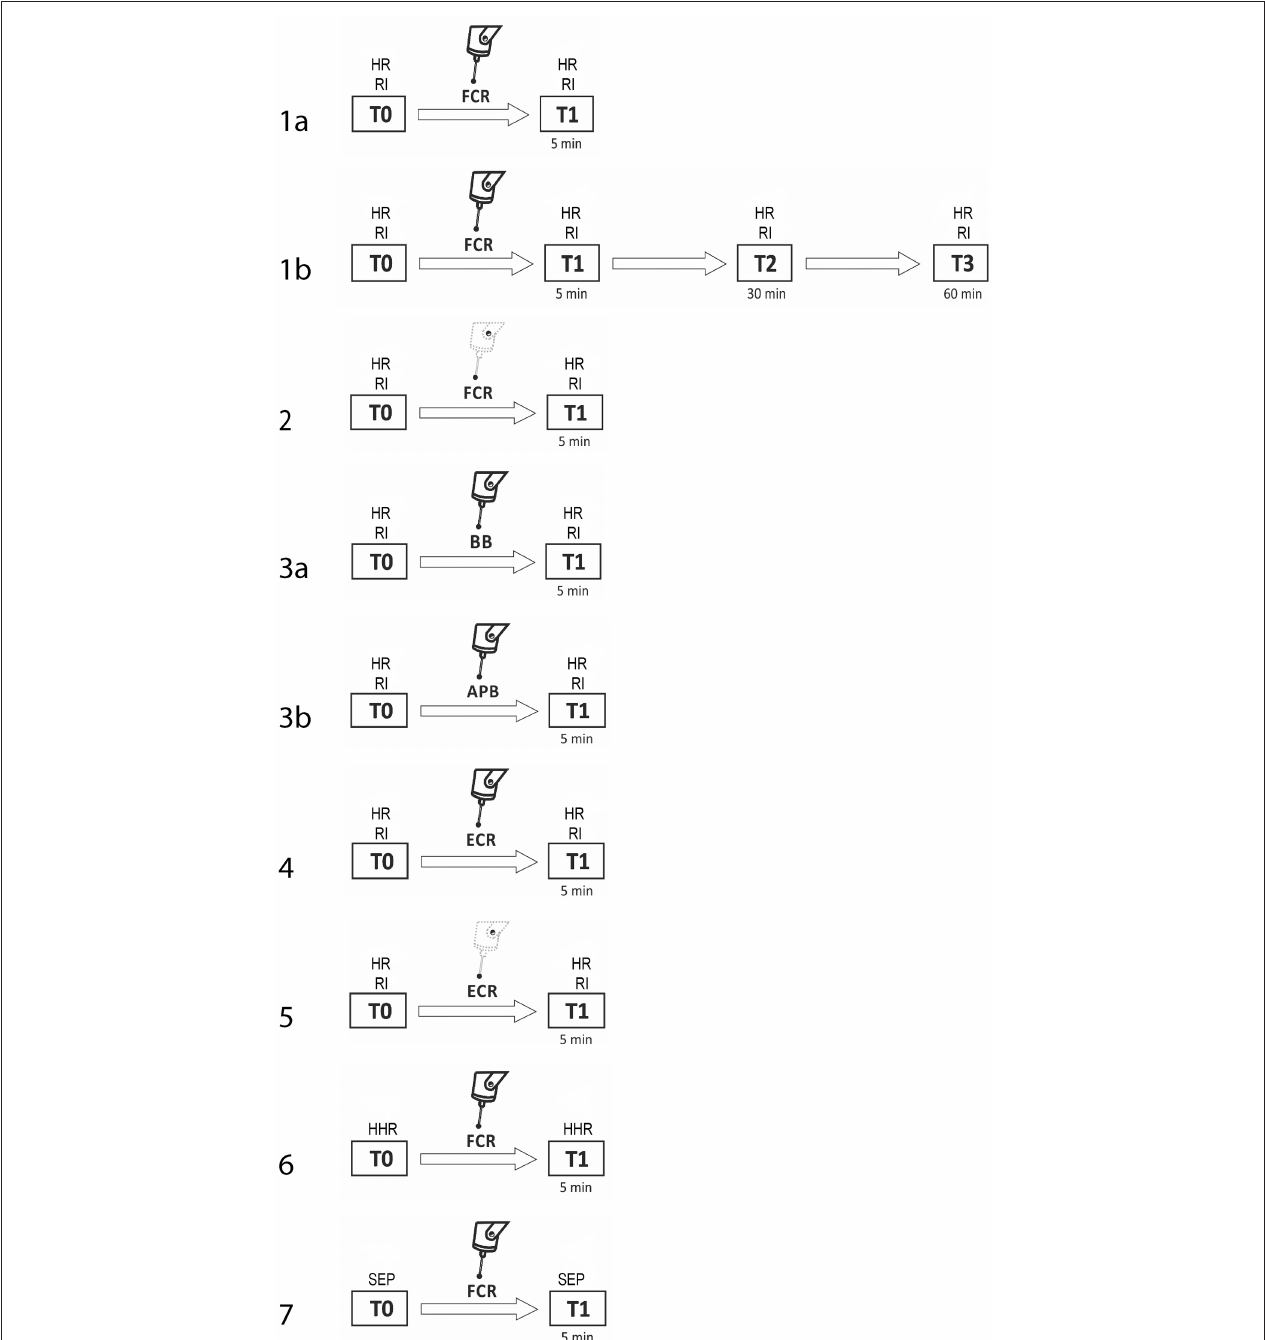
FIGURE 1 | Experimental procedures with regard to RI testing. The number on each row indicates the number of the experiment. Unconditioned HR and RI were investigated before (T0) and 5min after (T1) fMV applied over FCR (experiment 1a, first line), ECR (experiment 4, sixth line), BB (experiment 3a, fourth line), and APB (experiment 3b, fifth line). The same time course was explored to investigate the effect of voluntary contraction alone of FCR (experiment 2, third line) and ECR (experiment 5, seventh line). In experiment 1b only (second line), the effect of fMV was tested 30 (T2) and 60 (T3) min after fMV applied over FCR. In experiment 6 and 7 HHR and SEP, respectively (eight and ninth line) were recorded before (T0) and 5min after (T1) fMV.